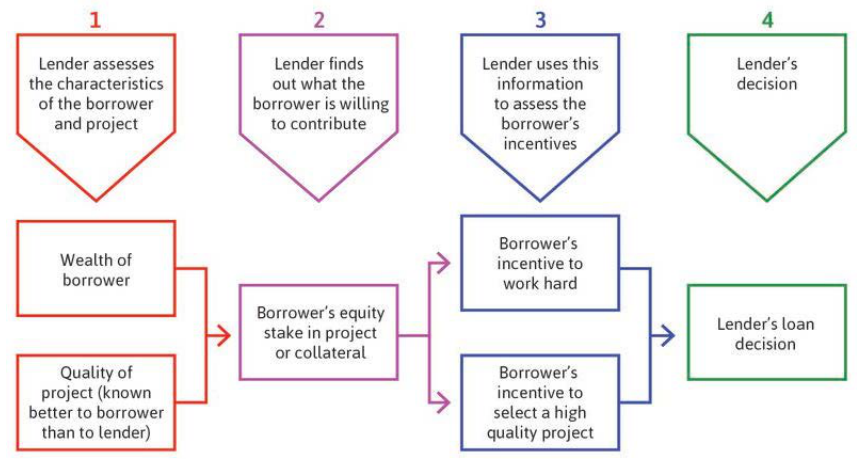
Fig. 1 The loan approval flow chart of nine rural commercial banks in the western